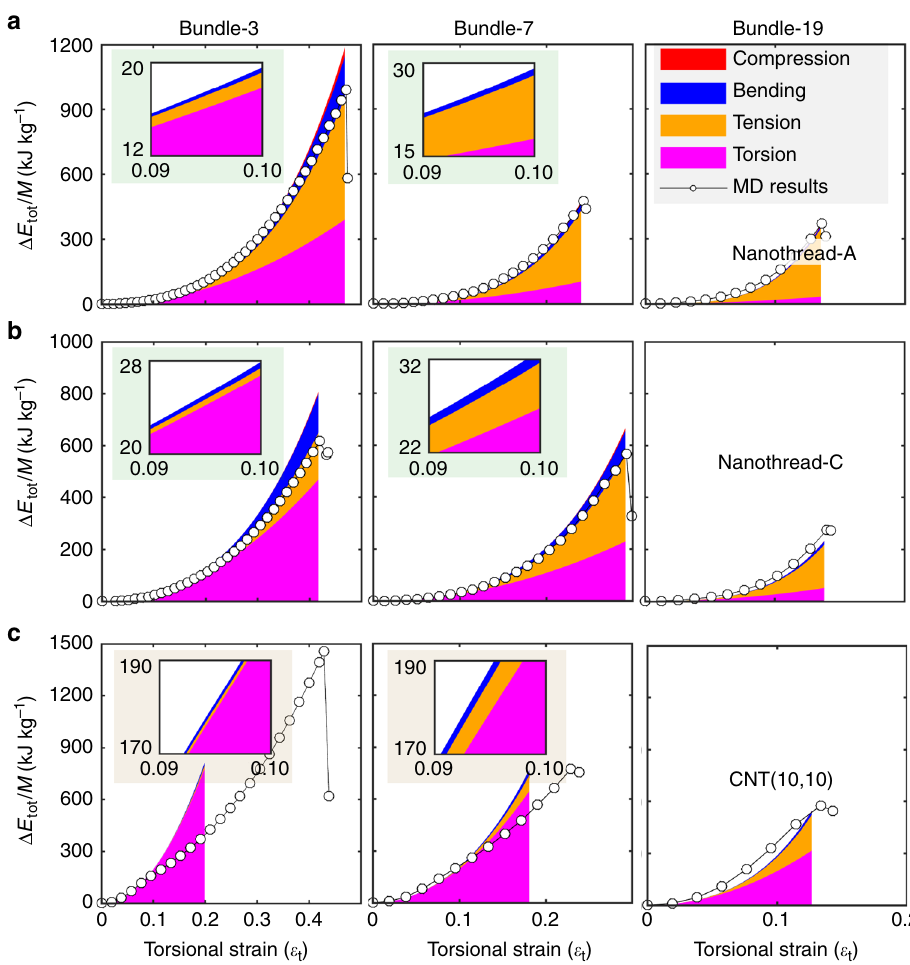
Fig. 5 Theoretical predictions of the contributions of different deformation modes. Strain energy density for bundle-3, -7 and -19 that are comprised of by: a Nanothread-A; b Nanothread-C and c